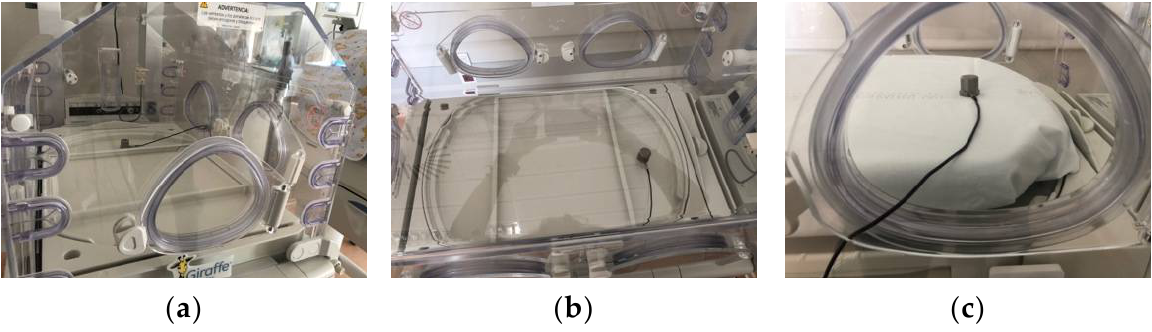
Figure 3. Examples of some of the recordings made on site in the neonatal incubator of the hospital. ( a ) Point 11 (correspond to the structure above the incubator motor). ( b ) Point 14 (correspond to the tray over the motor structure). ( c ) Point 17 (correspond to the mattress on the tray over the motor structure).